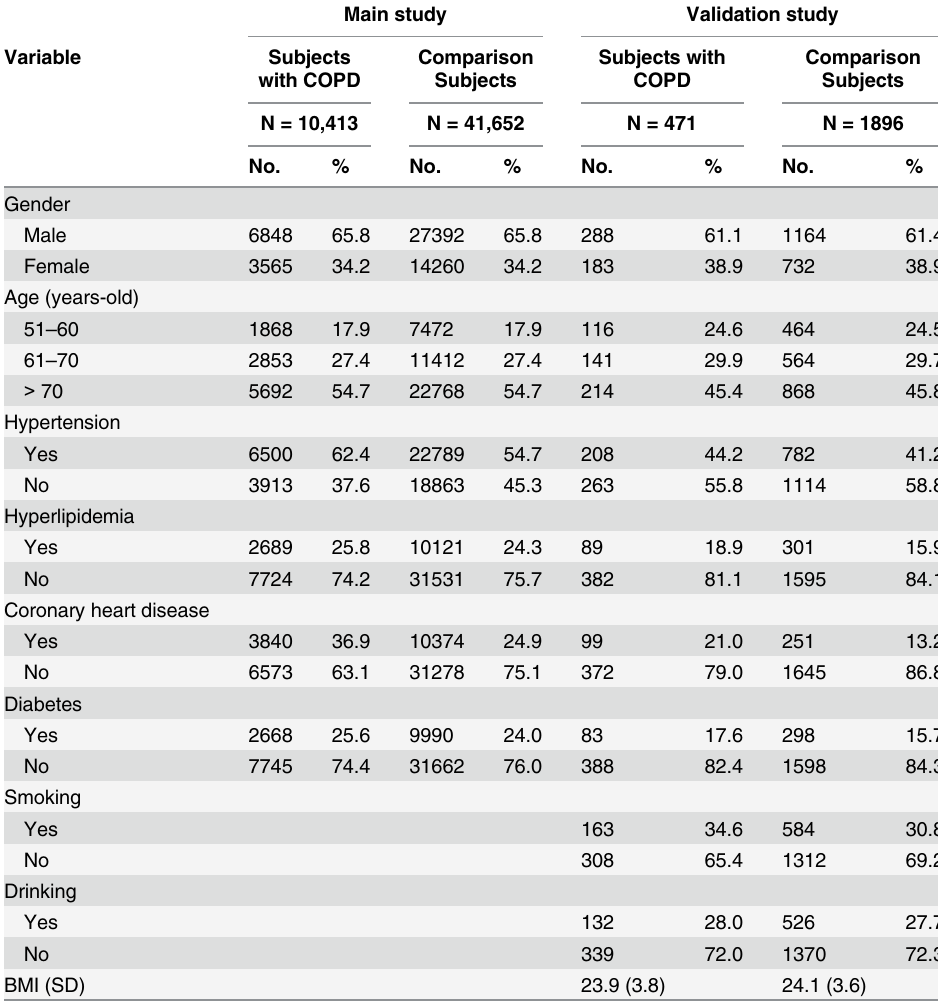
Table 1. Demographic Characteristics and Comorbid Medical Disorders for Subjects with COPD and in the Comparison Cohort in LHID main Database and NHIS validation Database, 2004 – 2006. Main study Validation